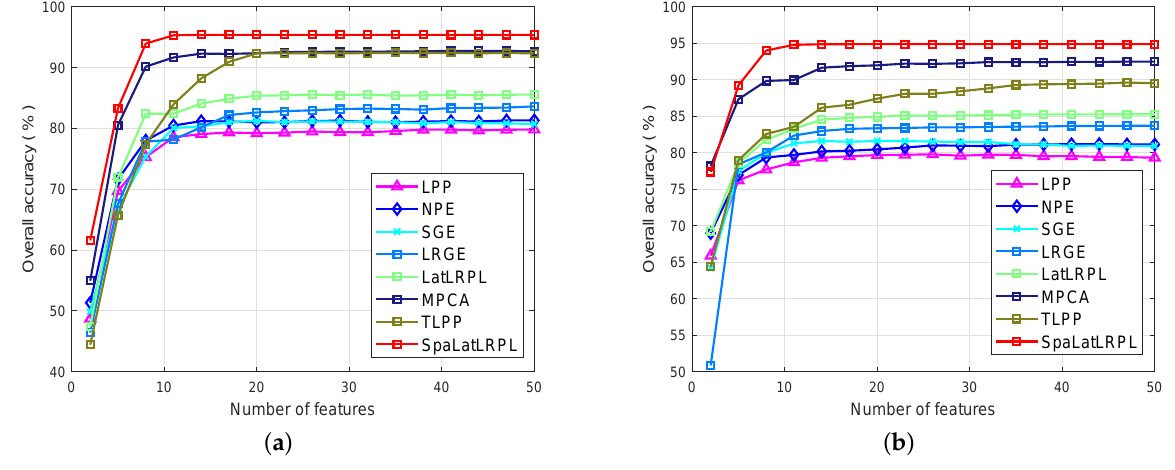
Figure 5. Parameter analysis of the number of preserved features: ( a ) Indian Pines, ( b ) Pavia